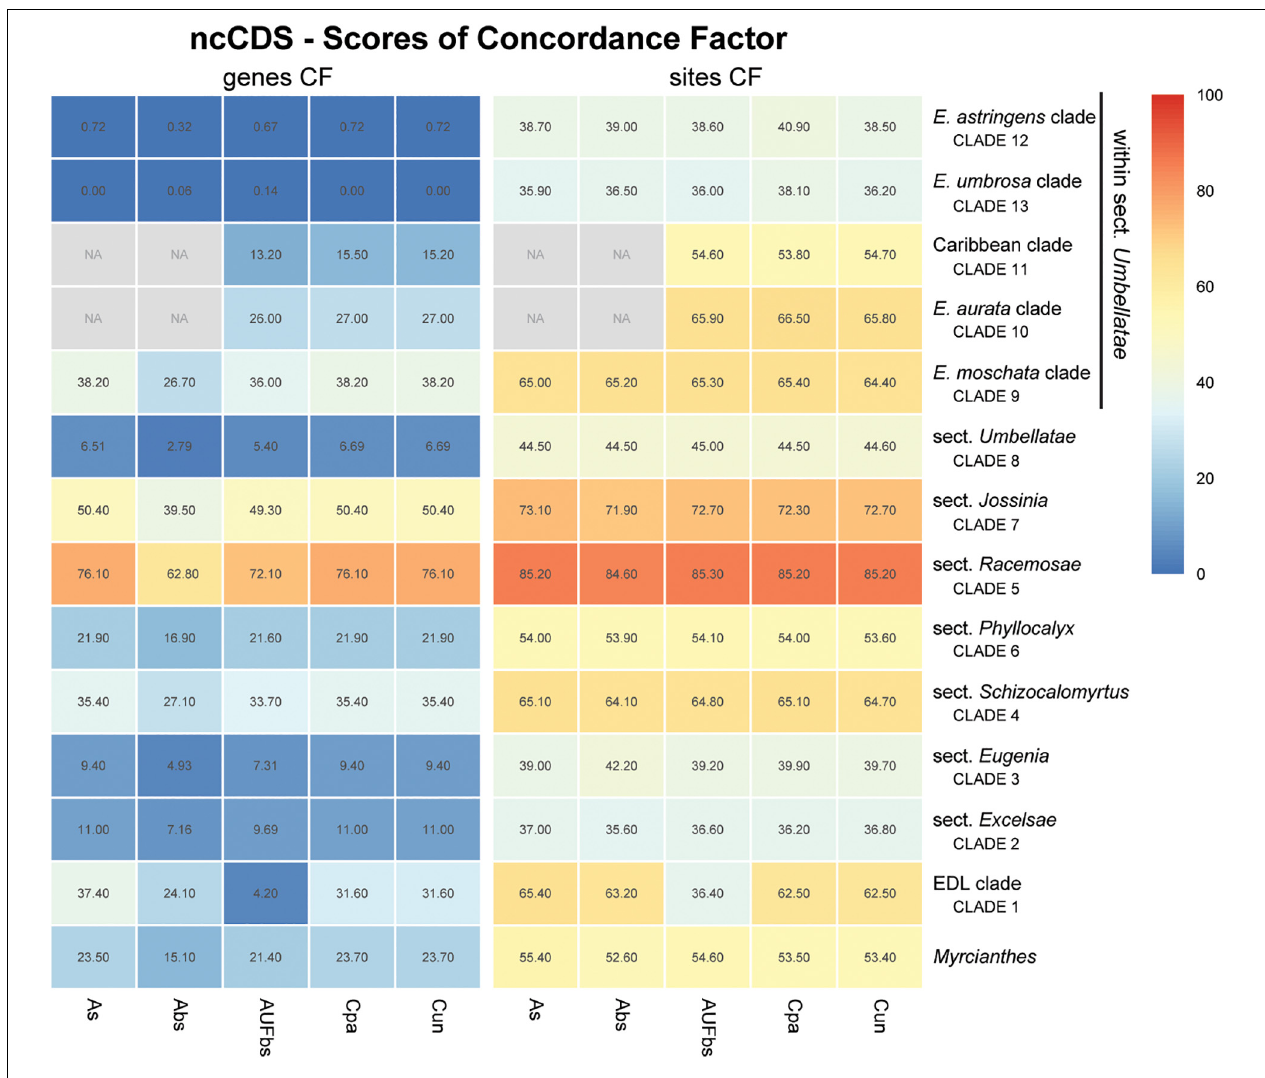
FIGURE 6 | Heatmap of gene and site concordance factors (gCF and sCF) recovered in focus clades of the nuclear coding loci (ncCDS) in Eugenia . Each column is a method of phylogenetic reconstruction, and each row corresponds to a clade in Figures 2–4 . Shading indicates percentage of concordance factor values recovered (Cpa, concatenated and partitioned ML reconstruction; Cun, concatenated and unpartitioned ML reconstruction; As, coalescent Astral tree with local posterior probability support; Abs, coalescent based Astral tree with 100 bootstrap replicates; AUFbs, coalescent Astral tree with 1,000 ultrafast bootstrap replicates; NA, node not